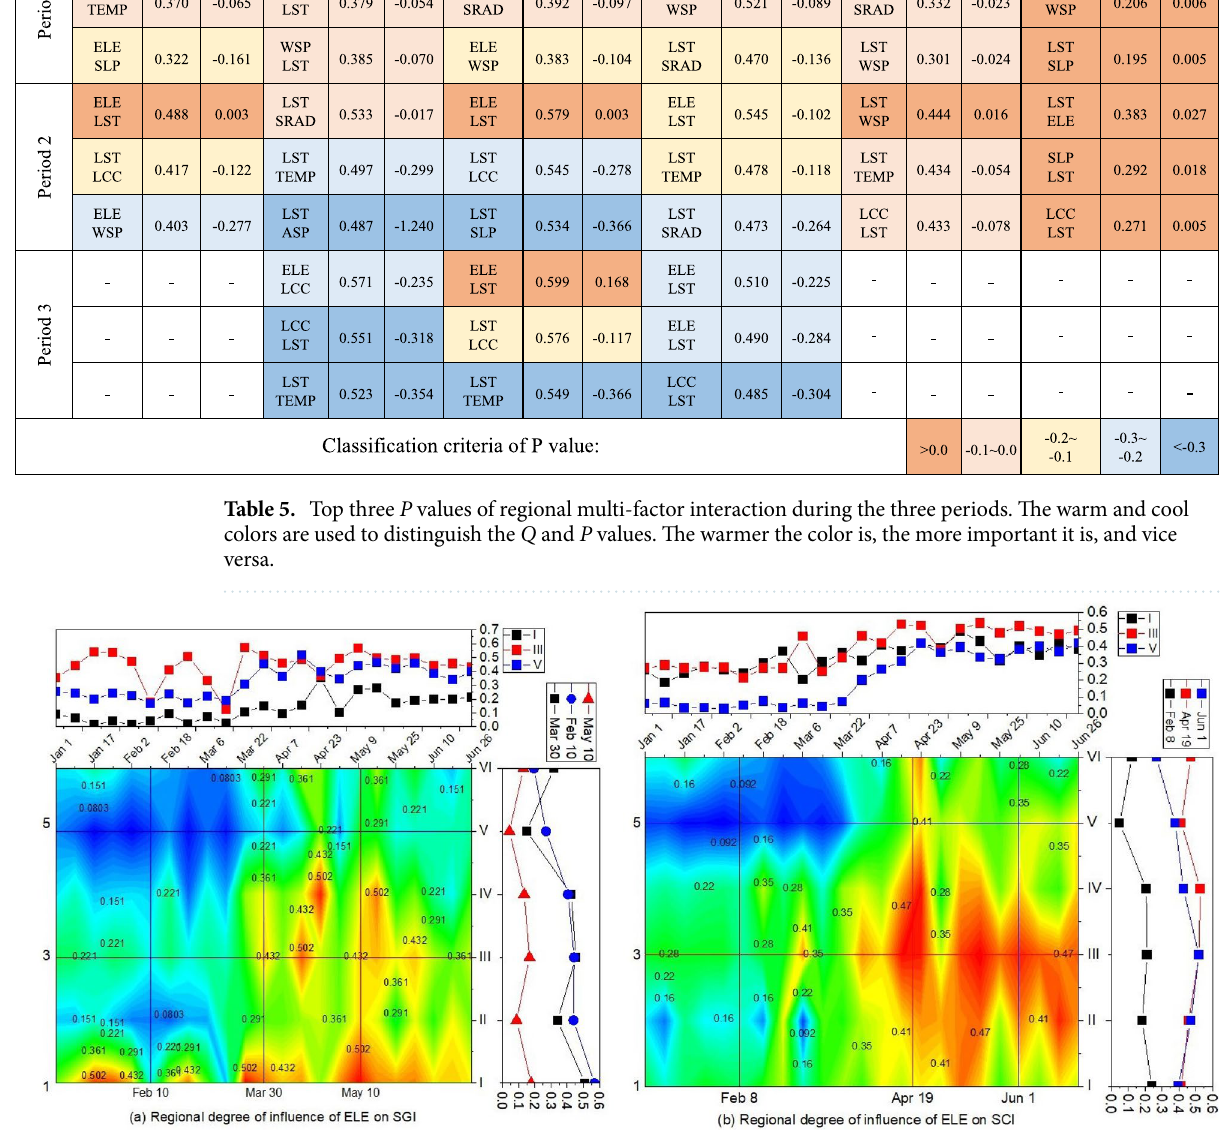
Figure 7. Spatiotemporal variations in the regional degree of influence of ELE on SGI and SCI. Map created in OriginPro, Version 2021. OriginLab Corporation, Northampton, MA, USA. (https:// www. origi nlab.